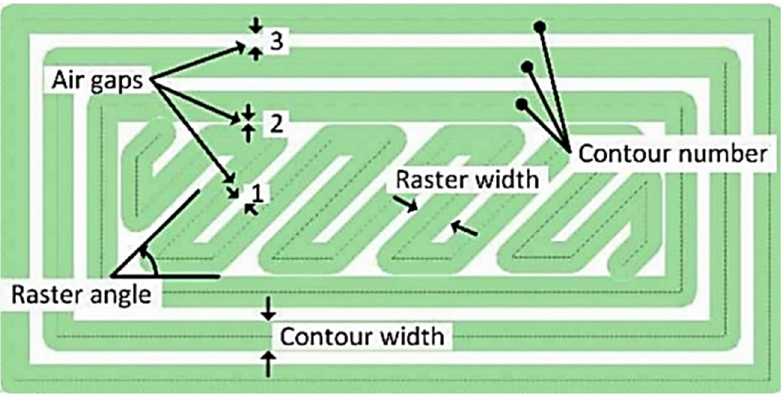
Figure 8. FDM processing parameters. Reprinted with permission from Ref. [82]. 2018, MDPI.